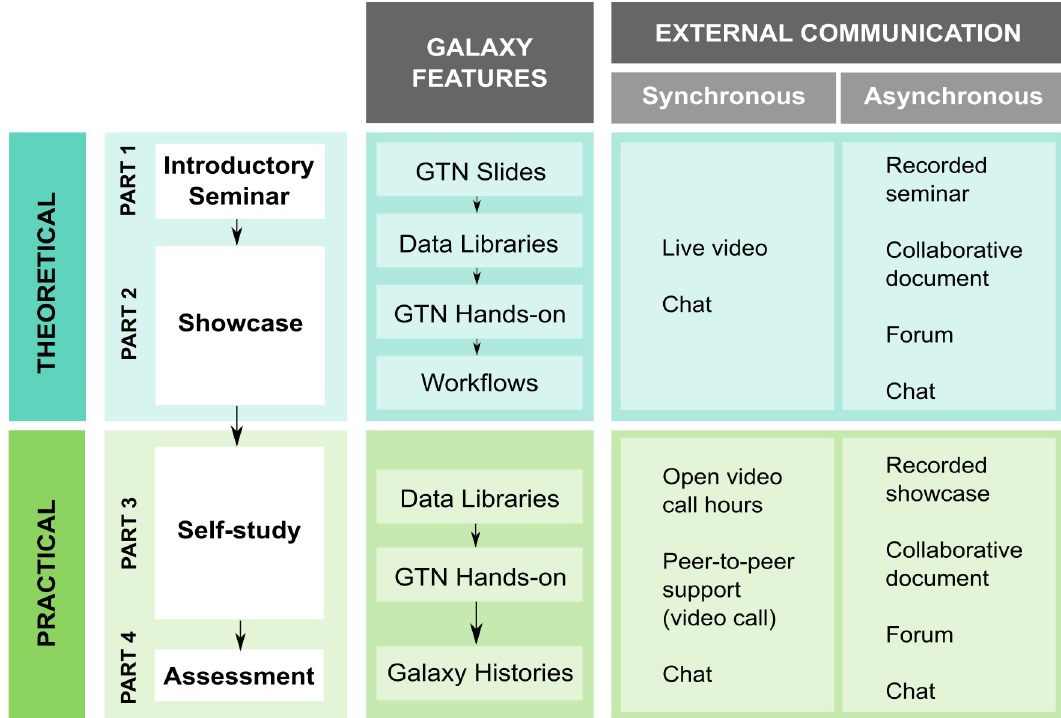
Fig 1. Proposed teaching format including theoretical using Galaxy features and external communication